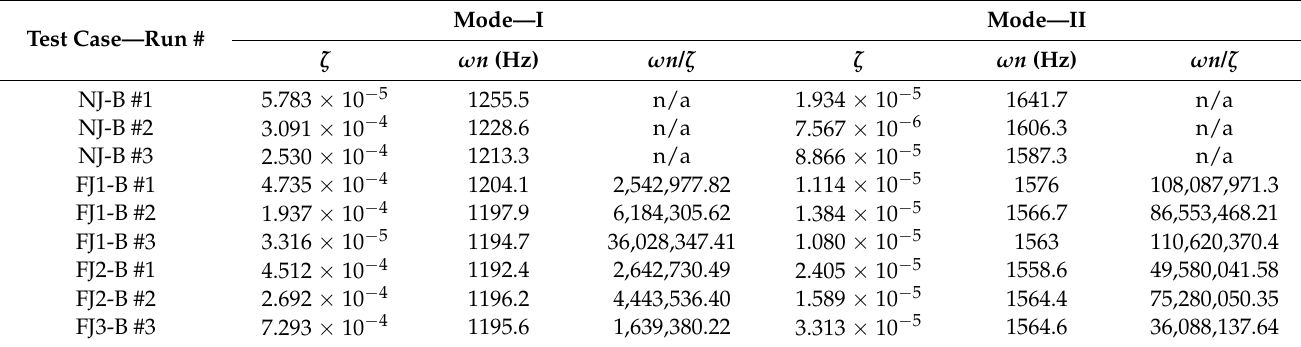
Table 3. Testing scenarios (at 80 Hz–800 mVpp) for detecting and identifying failing joints in structure-B.